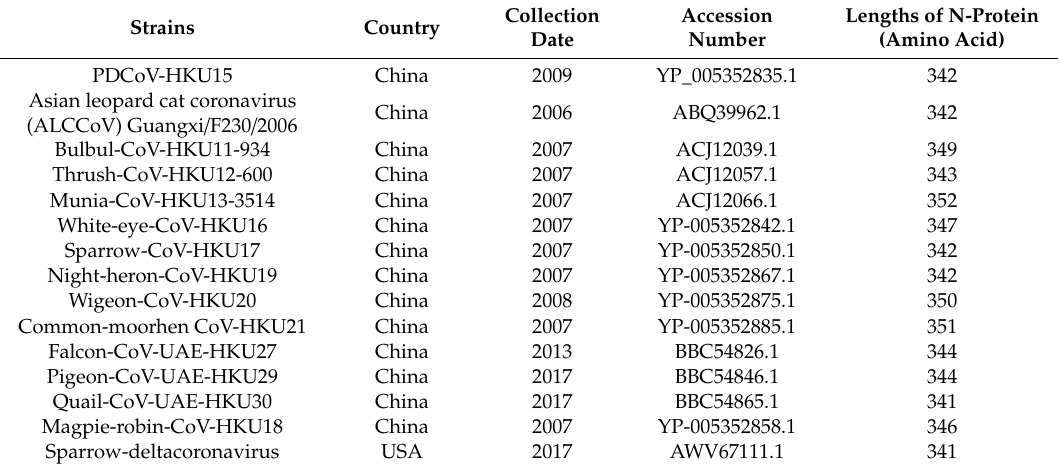
Table 3. Deltacoronavirus strains used for EP-4E88 sequence alignment.